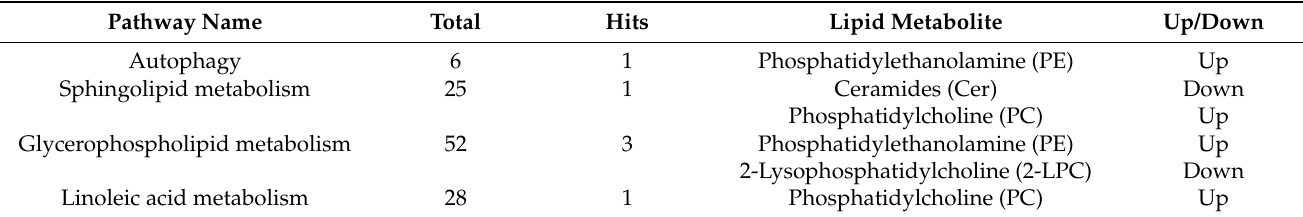
Table 6. The metabolic pathways of differential lipid metabolites in the liver of juvenile American eels in the PSPc0 group and PSPc900